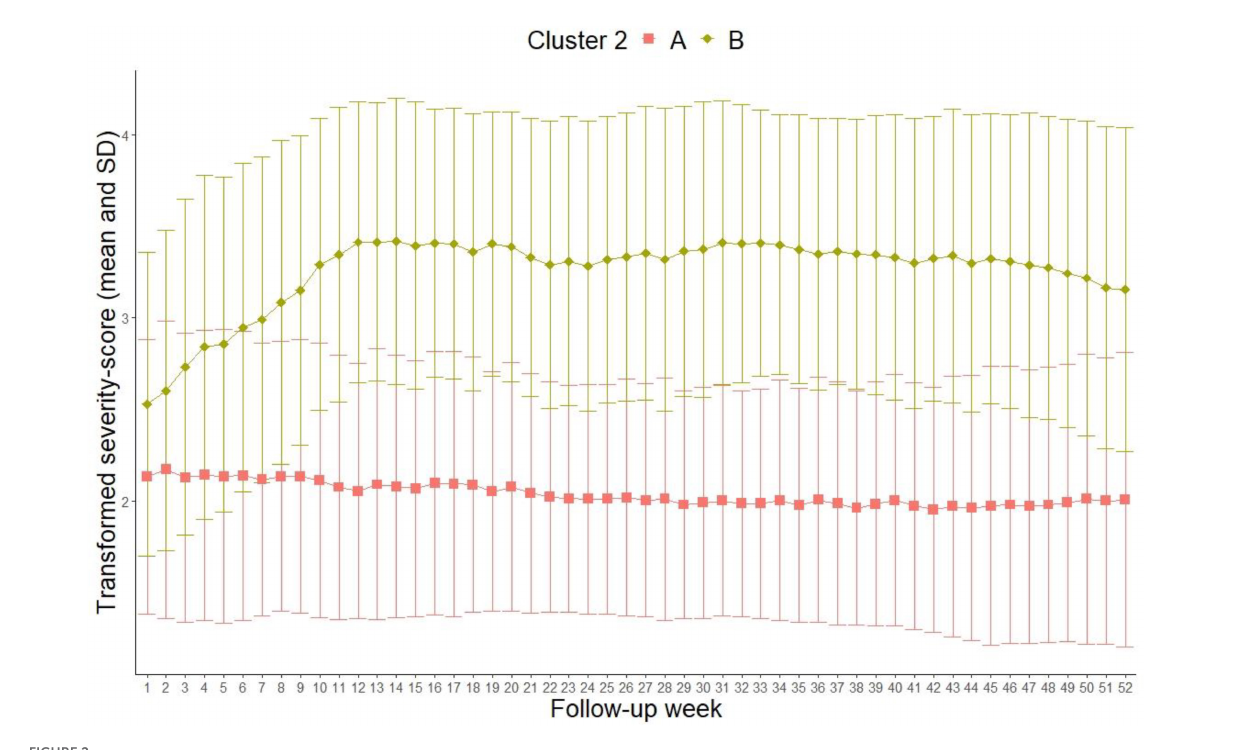
FIGURE2 2-cluster-solution (Transformed severity score out of MDE 6-point scale: 1 = 1 in MDE 6-point scale = healthy, 2 = 2 and 3 in MDE 6-point scale = residual symptoms and partial remission, 3 = 4 in MDE 6-point scale = depressive symptomatology without meeting full diagnostic criteria, 4 = 5 and 6 in MDE 6-point scale = meeting diagnostic criteria for unipolar depression and showing possible psychotic symptoms or extreme